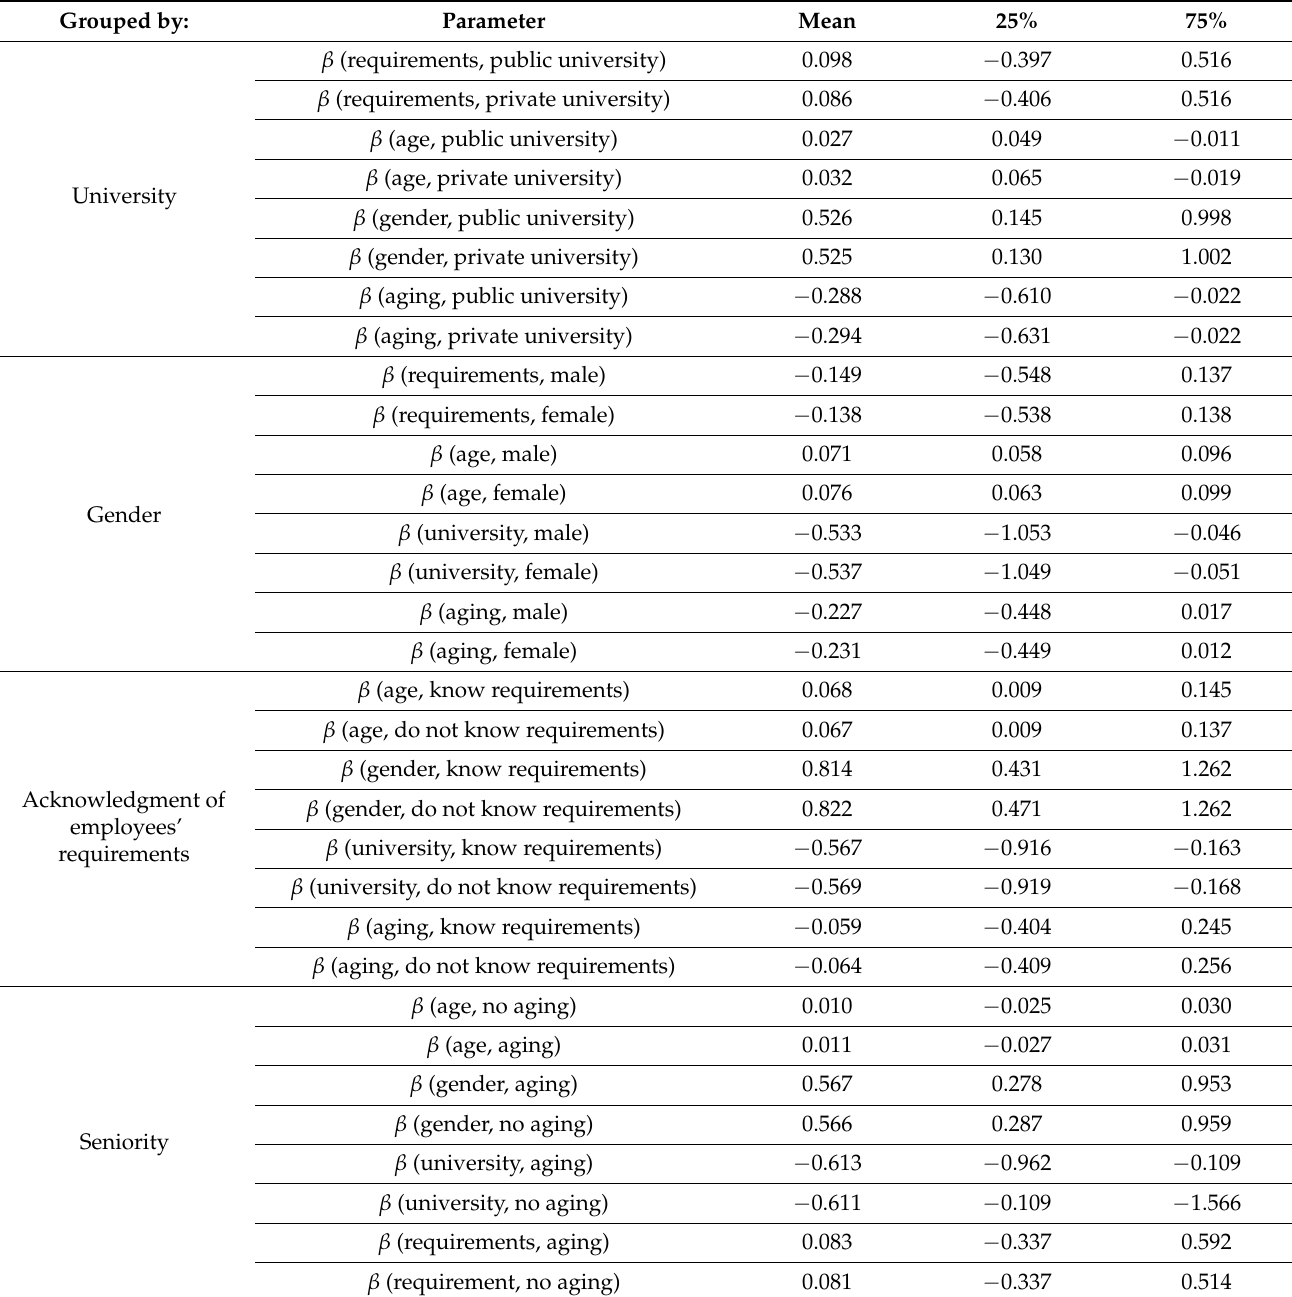
Table 1. The results of the posterior estimates robustness for explaining the scores associated to interview